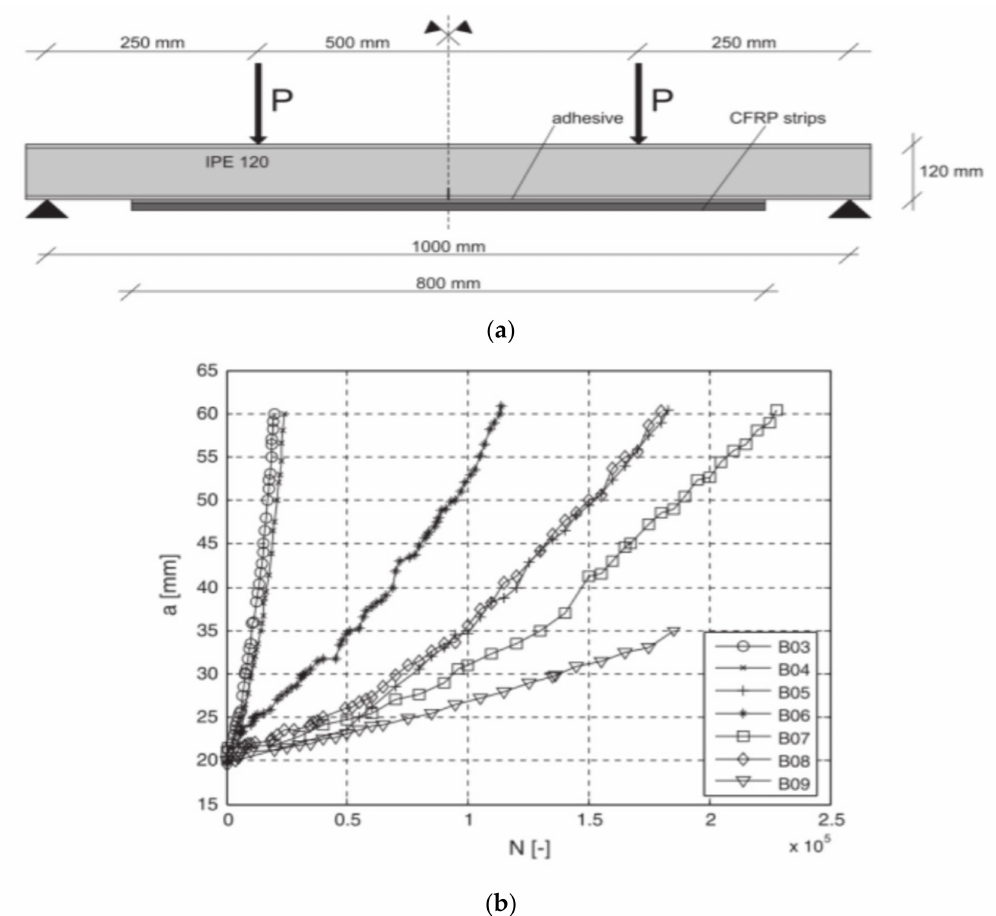
Figure 13. ( a ) Specimen and retrofitting geometry of repaired steel beams [148]; used with permission from Engineering Fracture Mechanics, Elsevier, 2021. ( b ) Crack propagation curves for specimens repaired with one layer (B03, B04) and two layers (B05 to B09) [148]; used with permission from Engineering Fracture Mechanics, Elsevier,